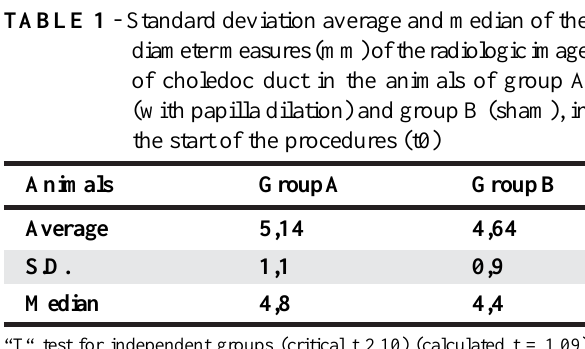
FIGURE 2 - To the right, radiologic image of vesicle (thick arrow) and extrahepaitc biliary ducts (thin arrow) representating an animal of group A before the dilation. To the left, radiologic image of the dilation balloon inflated in the choledoc duct (long arrow), papilla (arrow head) and duodenum (short arrow) of an animal of group A.